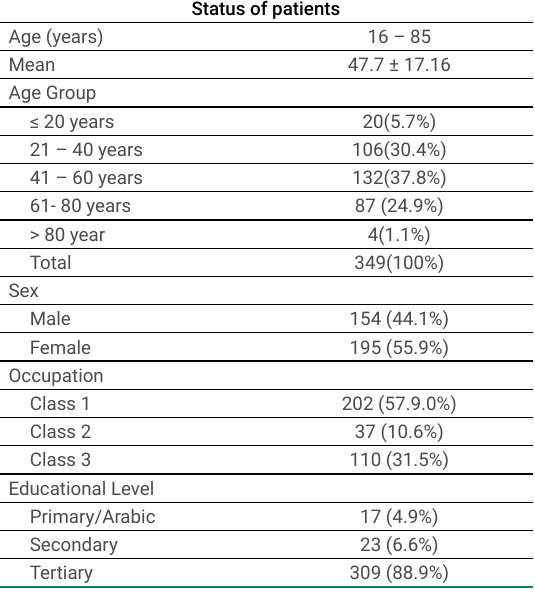
Table1. Socio demographic